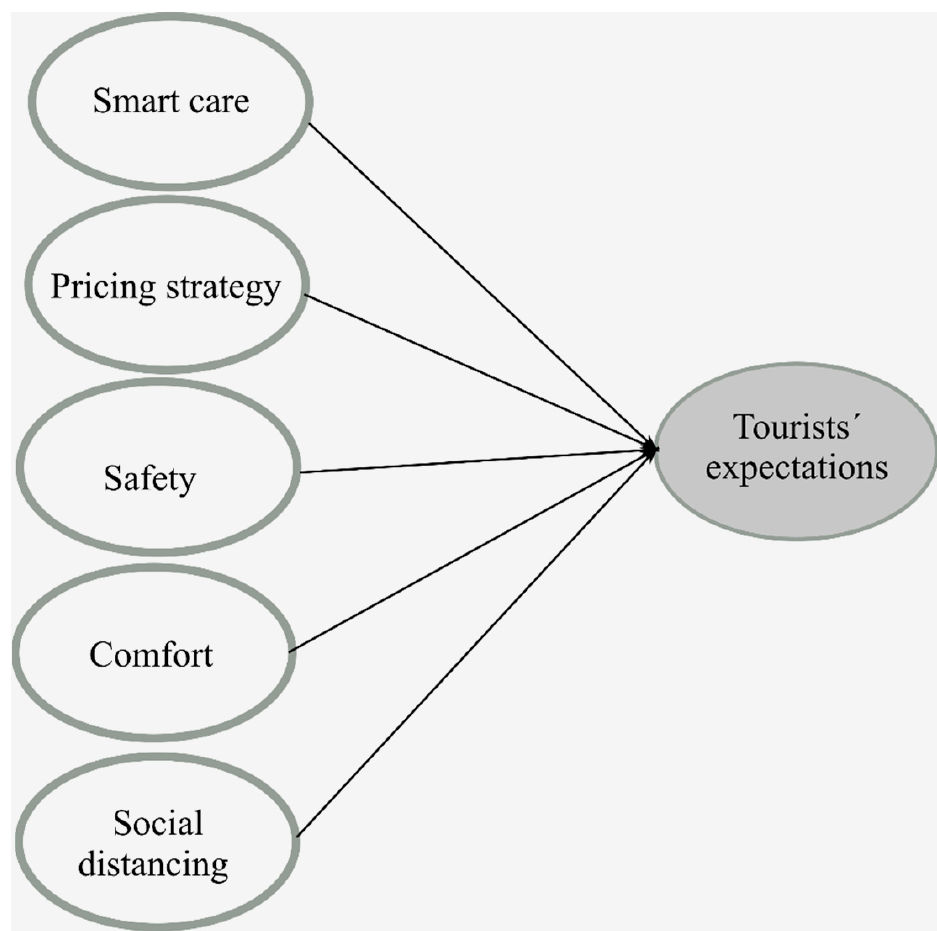
Figure 2. Tourists’ expectations for a destination in the post-COVID-19 recovery stage.